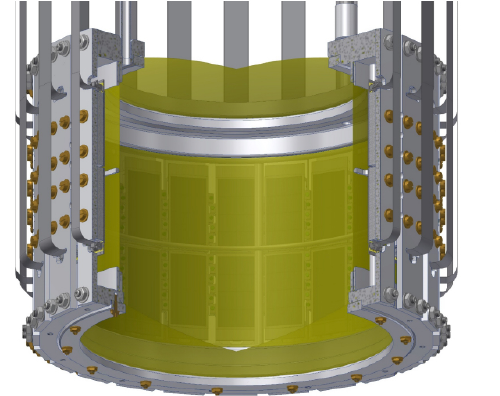
Figure 2. Design of the gas volume of SIDDHARTA 2 which provides the mandatory stabilty and the transmission for X-rays. The volume will be surrounded by arrays of X-ray detectors and shielding devices.